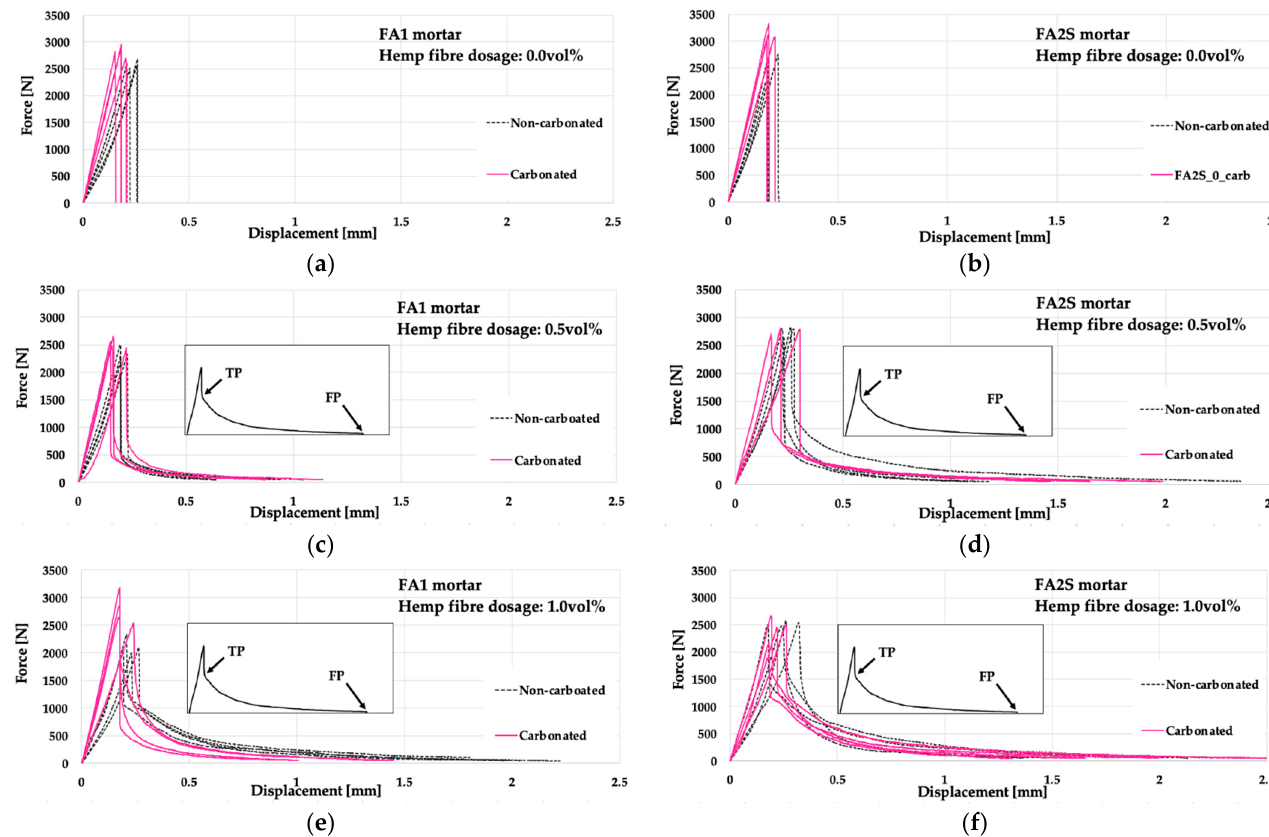
Figure 5. Force-midspan deflection curves of fly-ash-based (FA1) and fly-ash-and-slag-based (FA2S) mortars prior to [26] and after accelerated carbonation.